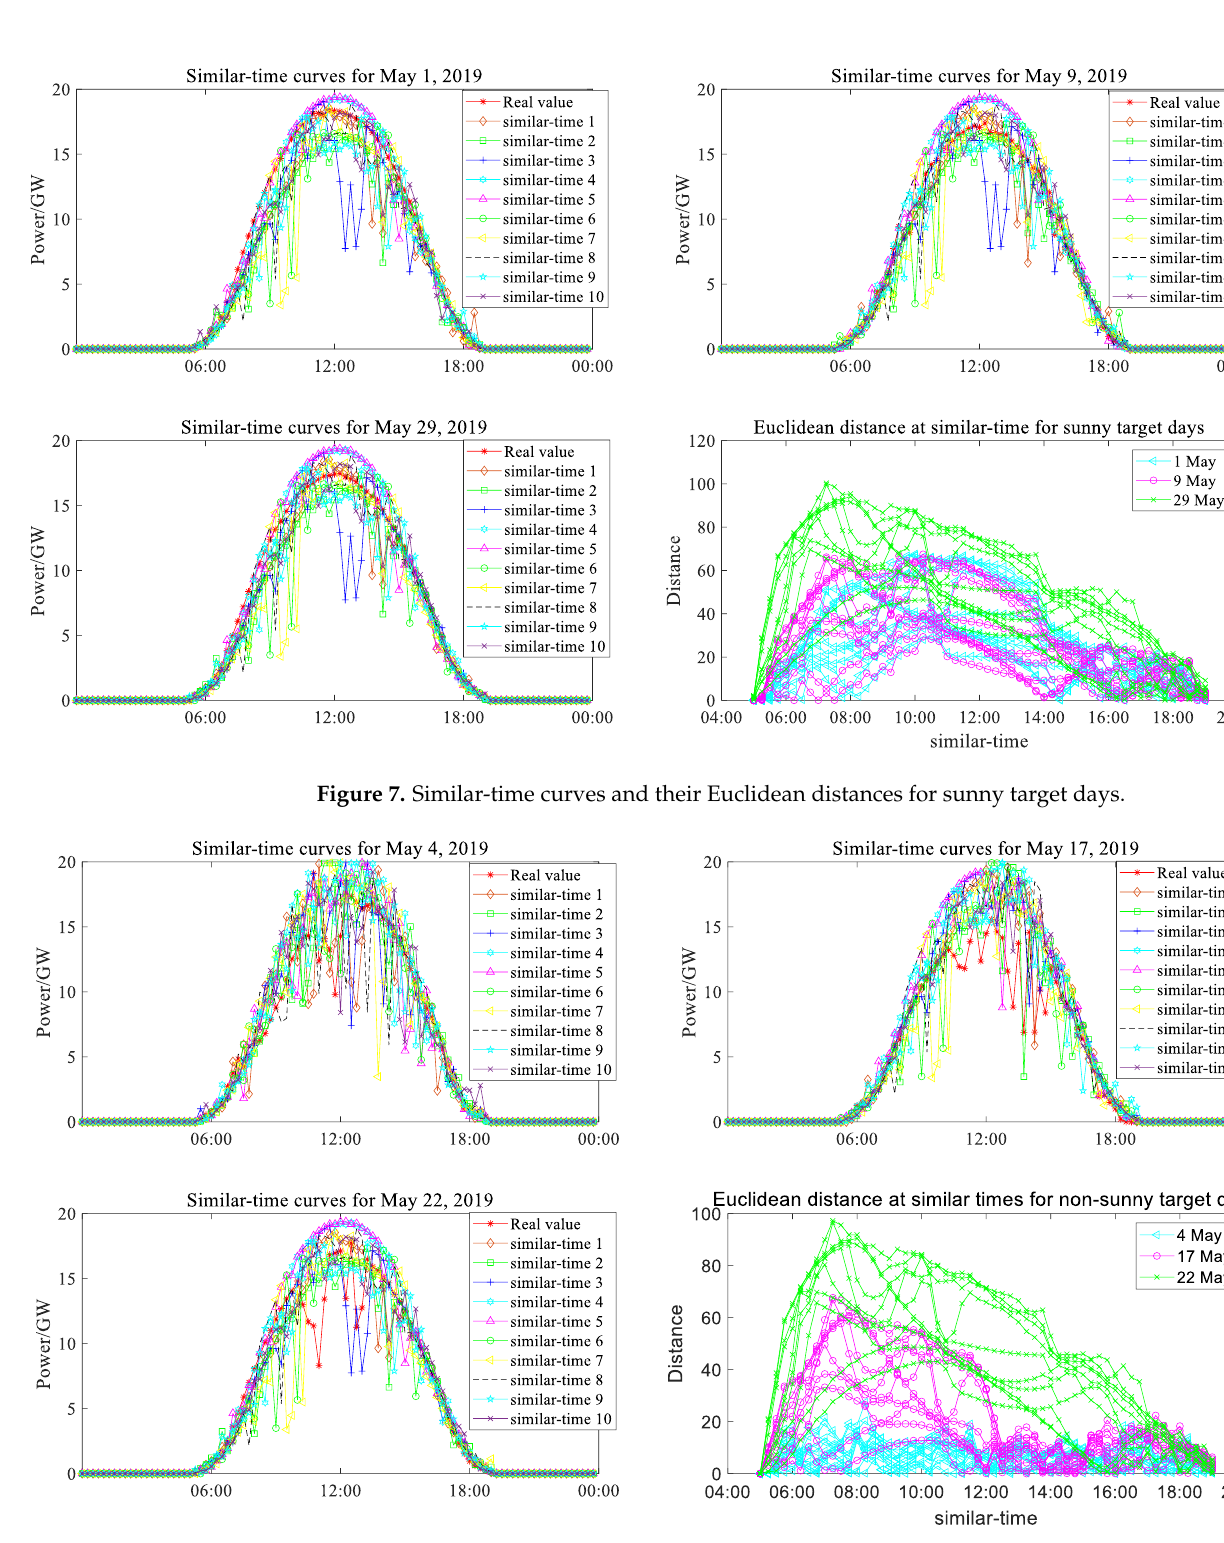
Figure 8. Similar-time curves and their Euclidean distances for non-sunny target days. Table 1. Ranking of feature